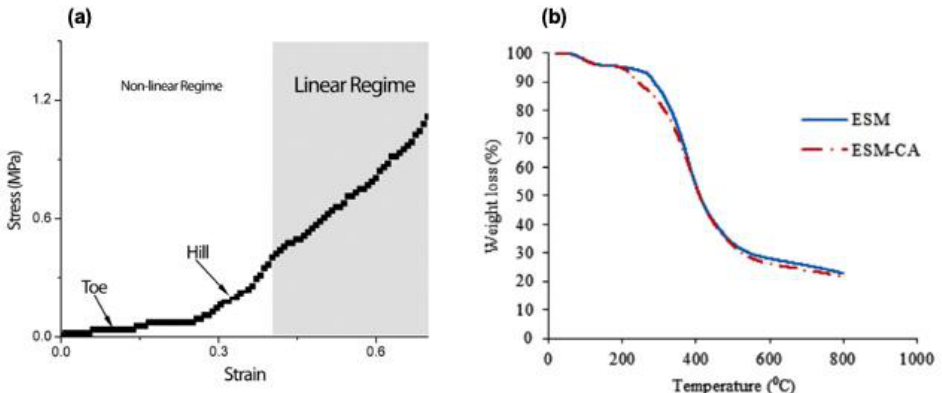
Figure 8. ( a ) Stress – strain curve representation for eggshell membrane. Image reproduced